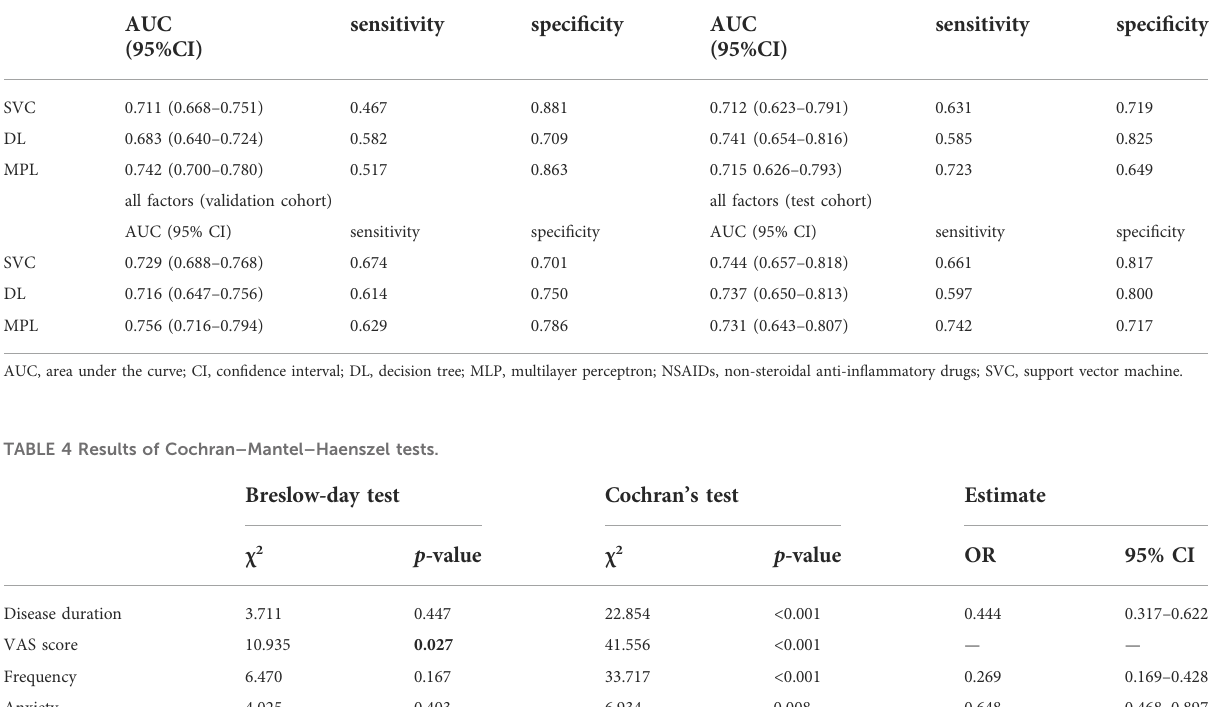
Table S1. The Breslow-Day test for homogeneity of ORs across NSAIDs yielded non-signi fi cant results for all independent risk factors (except for VAS, p = 0.027), i.e., the distribution of ORs across NSAIDs for each risk factor is compatible with that